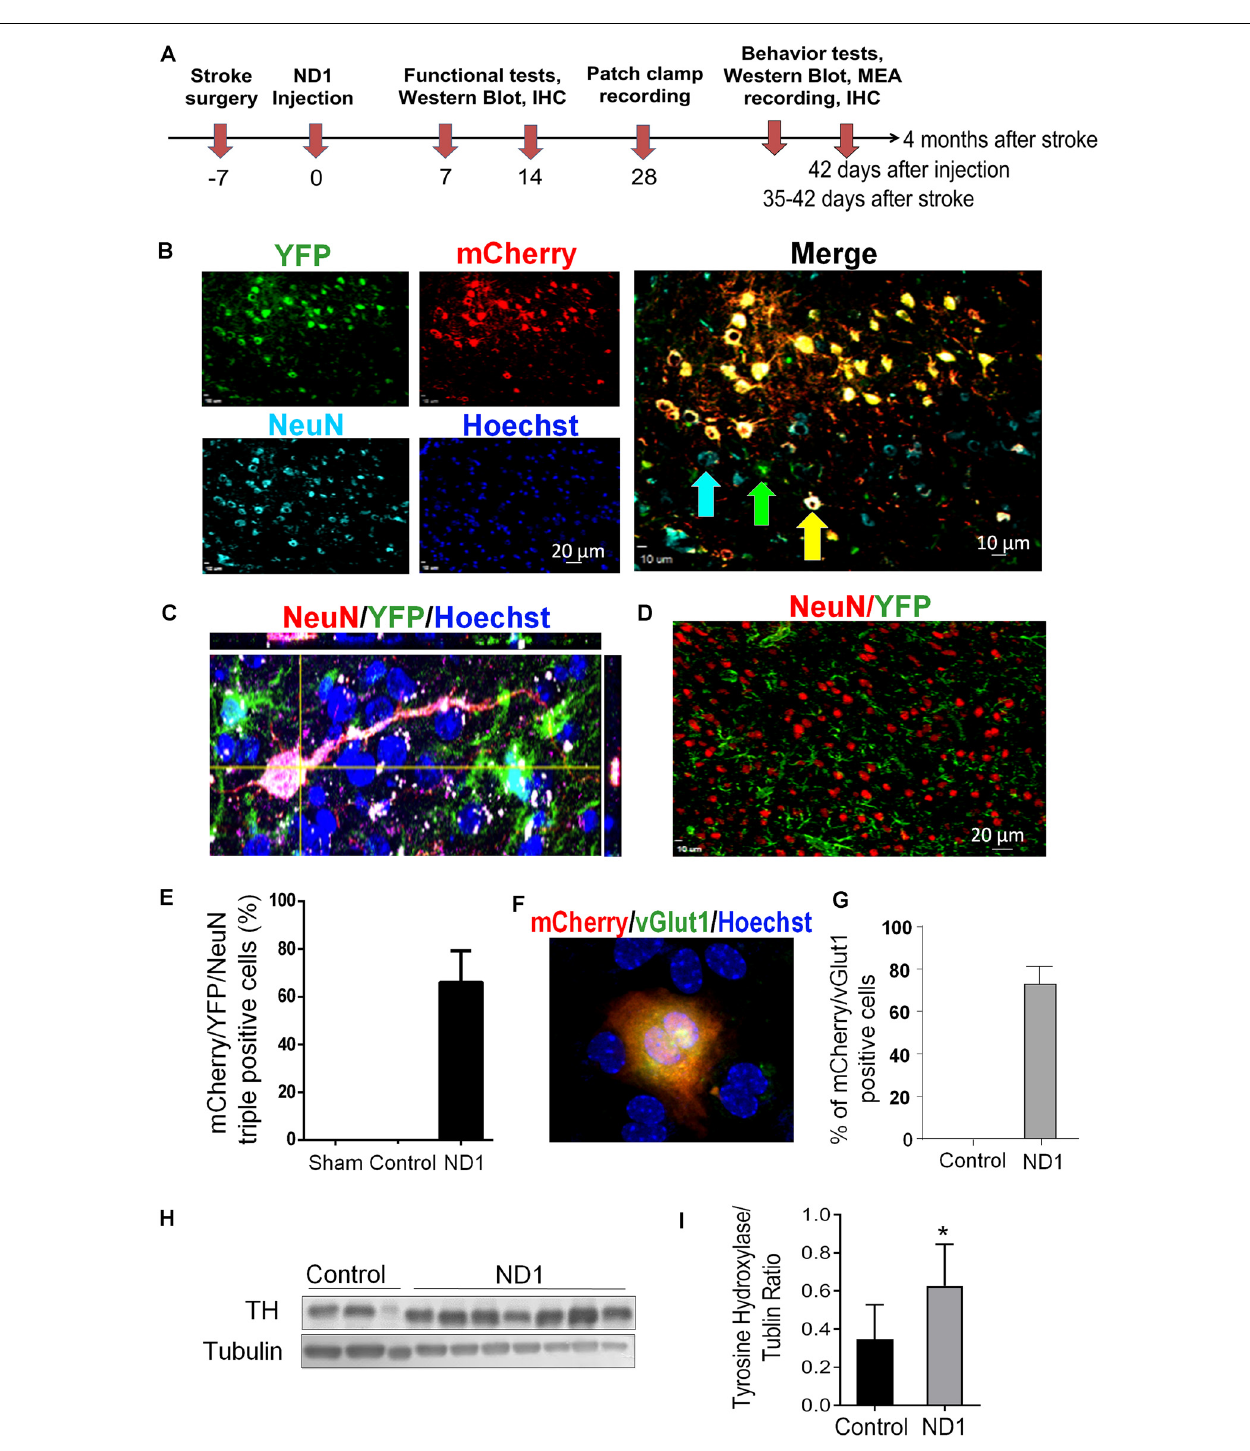
FIGURE 3 | Conversion of astrocytes to mature neurons in vivo . Adult GFAP-Cre x Rosa-YFP mice were subjected to a focal ischemic insult to the right sensorimotor cortex and subjected to control and ND1 treatments. (A) Timeline of in vivo reprogramming experiments. Animals received sham, stroke control, or ND1 lentivirus injection to the peri-infarct region 7 days after stroke. empty control vector or ND1 lentivirus. Functional and psychological assessments were performed different days after stroke. Six weeks later, brain coronel sections were subjected to immunohistochemical staining with cell phenotype markers. (B) Representative images show cells expressing YFP (green, astrocytes), mCherry (red, ND1 infected cells), NeuN (light blue, mature neurons), and Hoechst 33342 (dark blue, nuclei of all cells). The enlarged merged image illustrates overlapped markers (yellow/orange), indicating astrocyte-converted iNeurons. (C) A